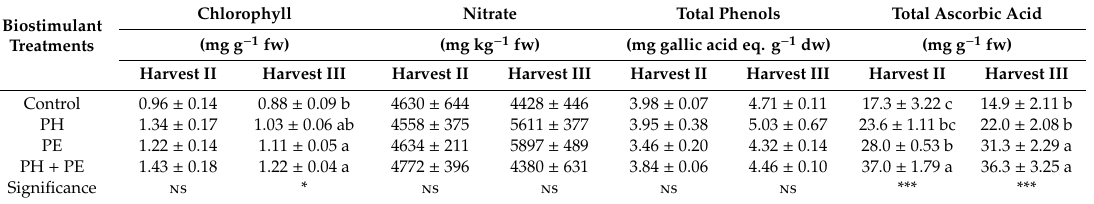
Table 4. E ff ect of foliar applications of protein hydrolysates (PH) and tropical plant extract (PE) alone or in combination on qualitative parameters of greenhouse cultivated perennial wall